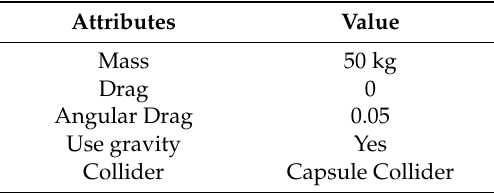
Table 2. Physical Parameters of